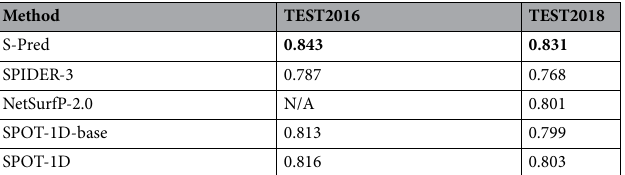
Table 4. Prediction of ASAs and comparison among methods. PCCs between the predicted and experimental values. The PCCs obtained from methods except S-Pred were used from the study conducted by Hanson et al. 8 . The method that performs the best is represented in bold.